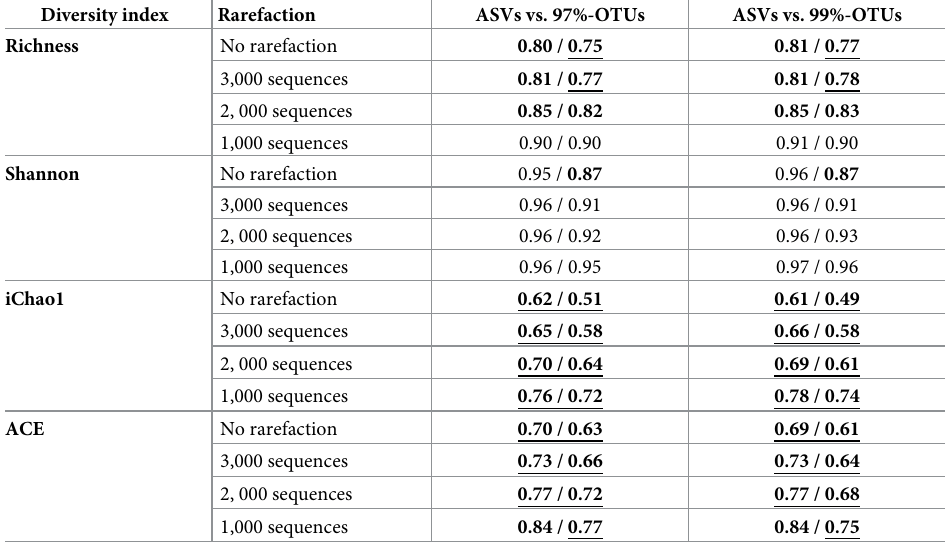
Table 1. Correlation between alpha diversity metrics between OTU- and ASV-based datasets across every rarefac- tion level